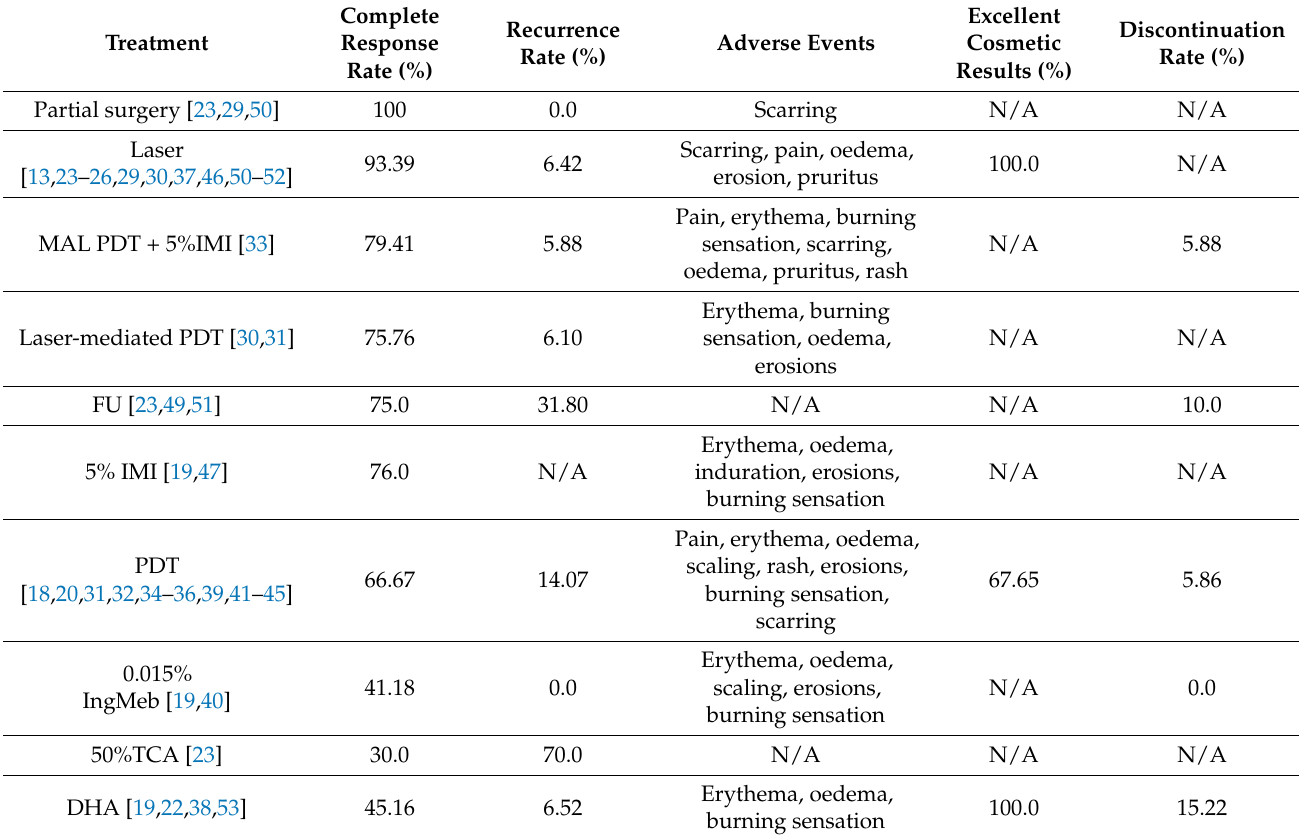
Table 2. Study results per treatment